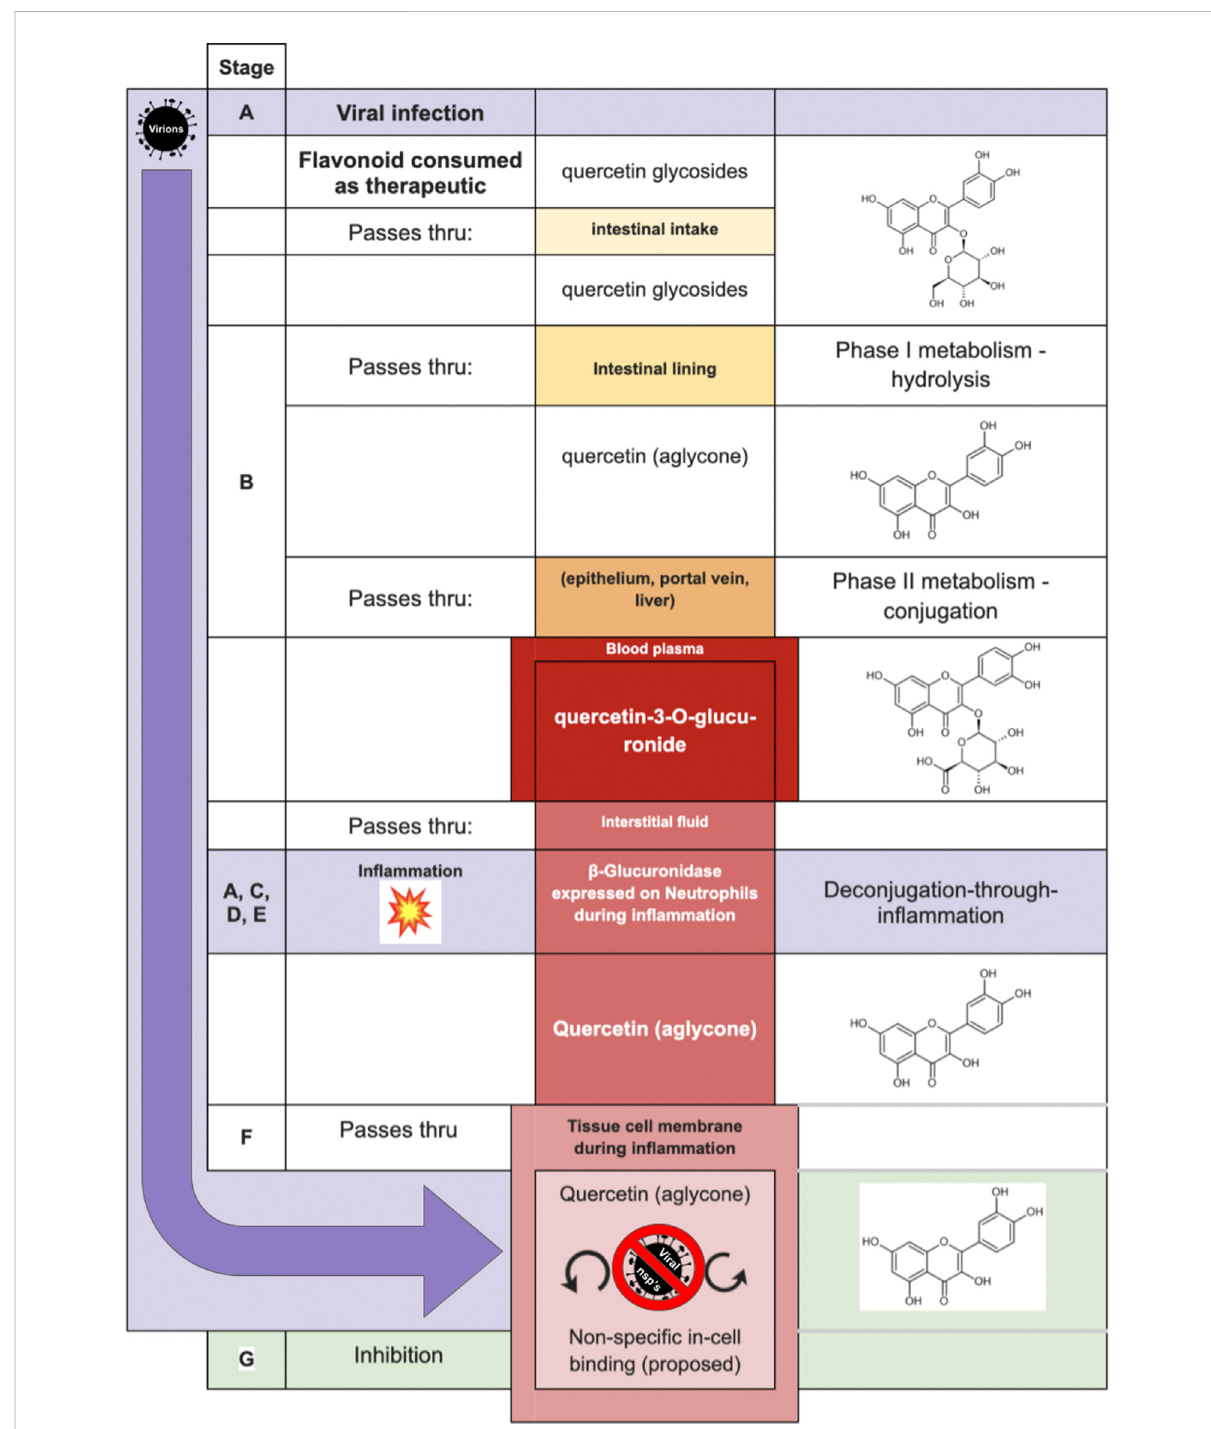
FIGURE 6 Proposed model of Shimoi mechanism for entry into intracellular compartment during viral infection, with quercetin serving in the role of the aglycone, and quercetin-3-O-glucuronide as the glucuronide [adapted from Perez-Vizcaino et al.